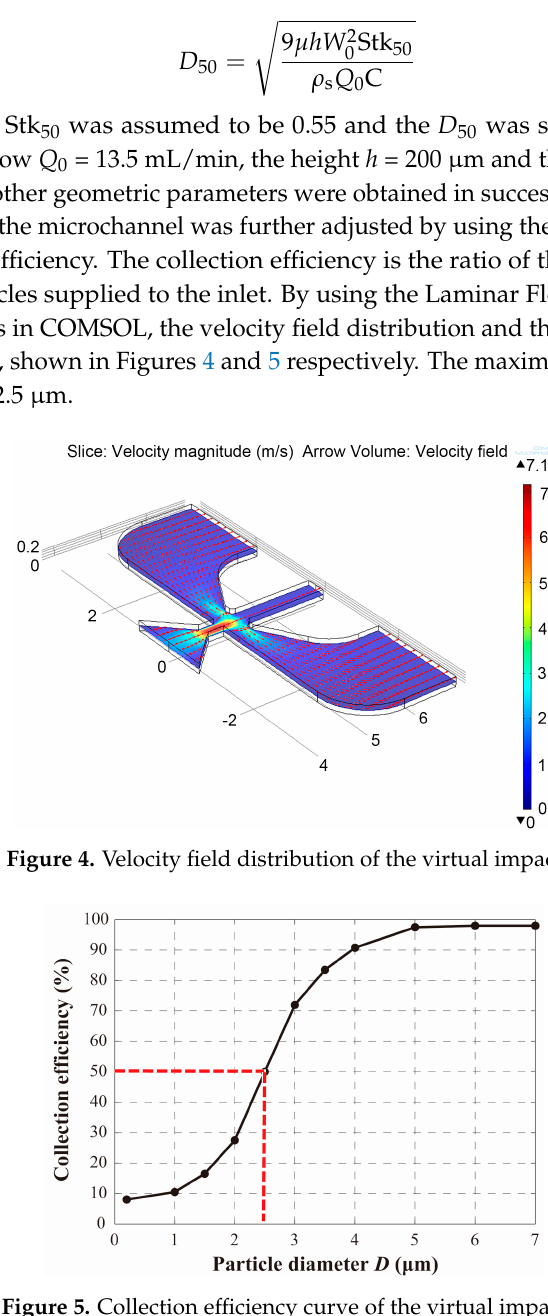
Figure 5. Collection efficiency curve of the virtual impactor.